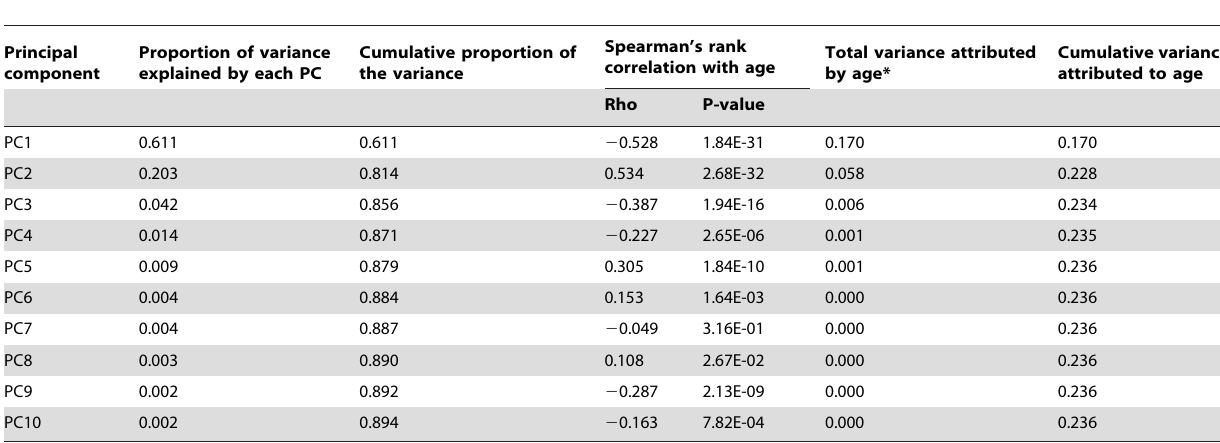
Table 2. Principal components for the DNA methylation levels among autosomal markers and corresponding correlation with age and variance.